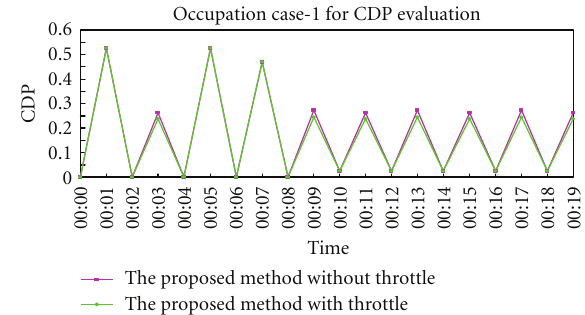
Figure 11: Comparison of CDPs without and with throttle for occupation